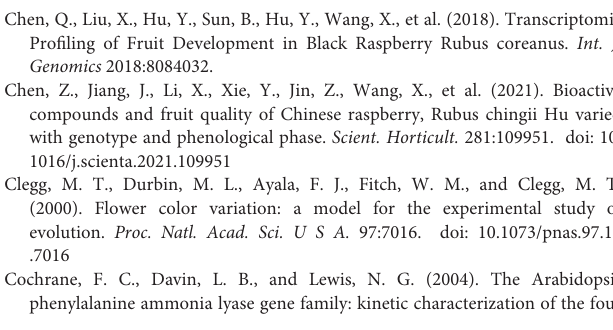
Supplementary Figure 1 | Composition of anthocyanins and flavonoids in R. chingii (Li et al., 2021a). The upper graph(s): electrospray product ion mass spectra; the lower graph(s): fragment ions mass spectra; shown to the right of the graphs: putative molecular structure and cleavage pattern. Supplementary Figure 2 | Summary of differentially expressed (A) genes and (B) proteins during four maturation phases in R. chingii . Supplementary Figure 3 | KEGG enrichment of the differentially expressed (A) unigenes and (B) protein isoforms. Bar size represents the number of genes enriched in a particular pathway. Up-regulated proteins between two phases are marked in red; down-regulated proteins between two phases are marked in blue. The biosynthesis of phenylpropanoid and flavonoid are shown in rectangles. Supplementary Table 1 | Primers for RT-qPCR